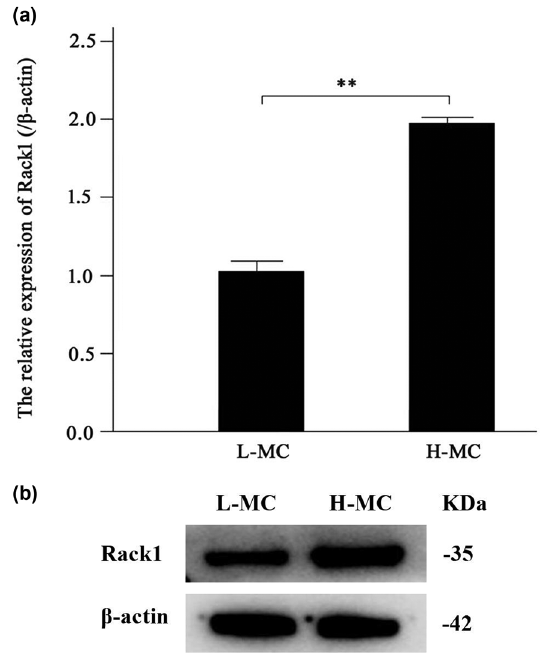
Figure 2: Rack1 was highly expressed in mesangial cells cultured with high glucose. ( a ) The expression of Rack1 was signi fi cantly increased in mesangial cells cultured with high glucose compared with that in cells of the low - glucose group by qRT - PCR. The data are representative of three independent experiments ( ** p < 0.01 ) . ( b ) The expression of Rack1 was signi fi cantly increased in mesangial cells cultured with high glucose compared with that in cells of the low - glucose group by western